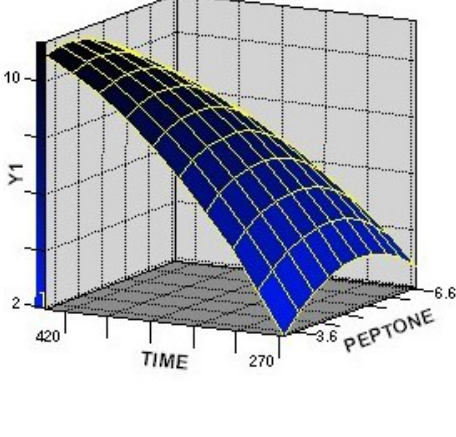
Figure 3. The surface plot of the combined effects of peptone and culture time on Y (GA-Me) production by G. lucidum . Fixed level: glucose concentration = 0 (coded